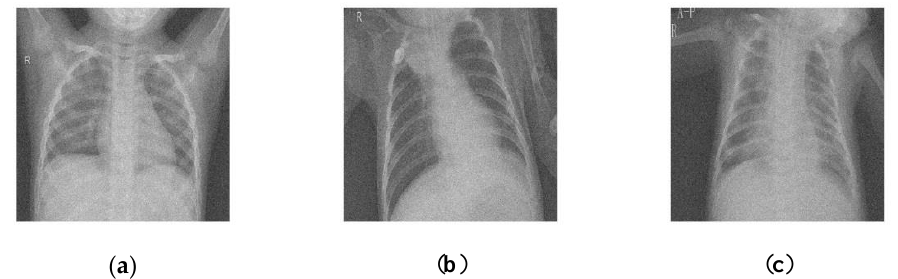
Figure 6. Noisy input CT image dataset (noise level = 25). ( a ) Noisy CT1 image; ( b ) Noisy CT2 image; ( c ) Noisy CT3 image.